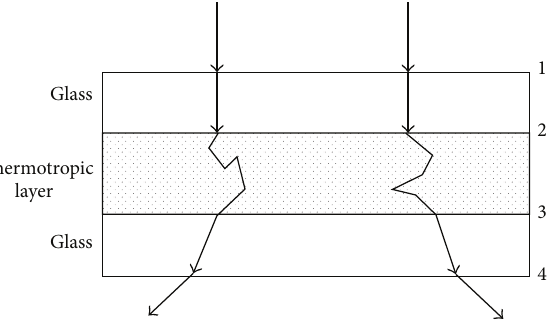
Figure 1: The three-layer structure of a thermotropic window.